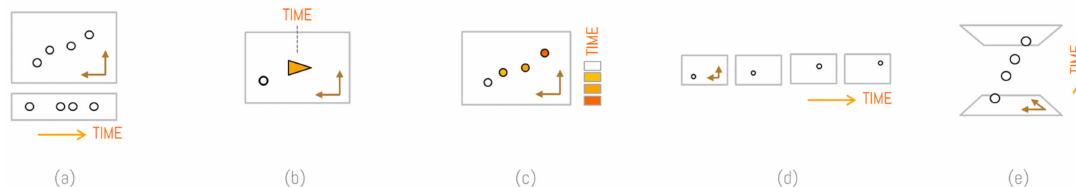
Figure 4. Hybrid views for visualizing spatial (brown) and temporal (orange) data dimensions in combination: ( a ) multiple coordinated views, ( b ) animation or slideshow, ( c ) color-coded layer superimposition, ( d ) layer juxtaposition and ( e ) space–time cube